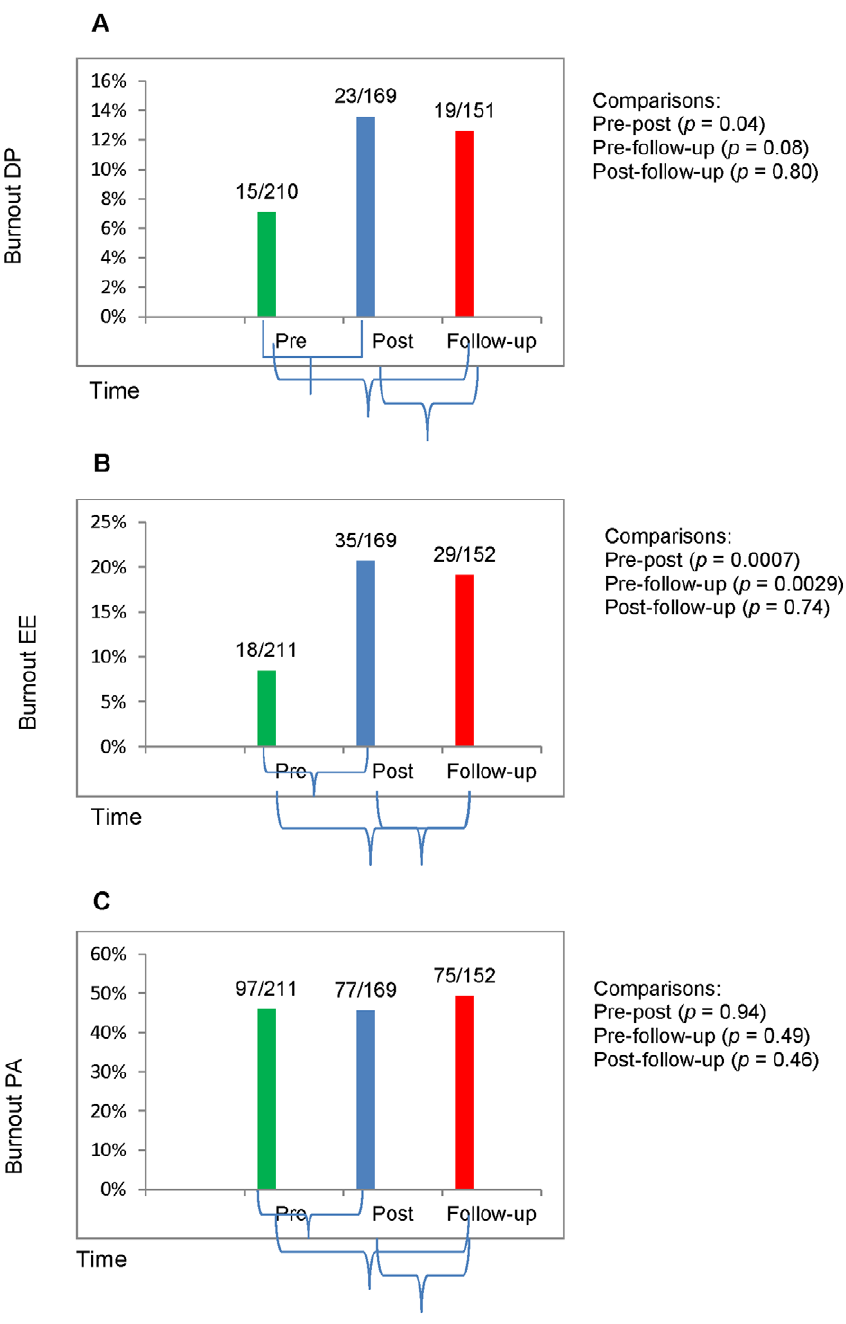
Figure 2. Burnout Outcomes. Burnout outcomes at pre-deployment (N=210 or 211), post-deployment (N=169), and follow-up (N=151 or 152) 3–6 months after returning from